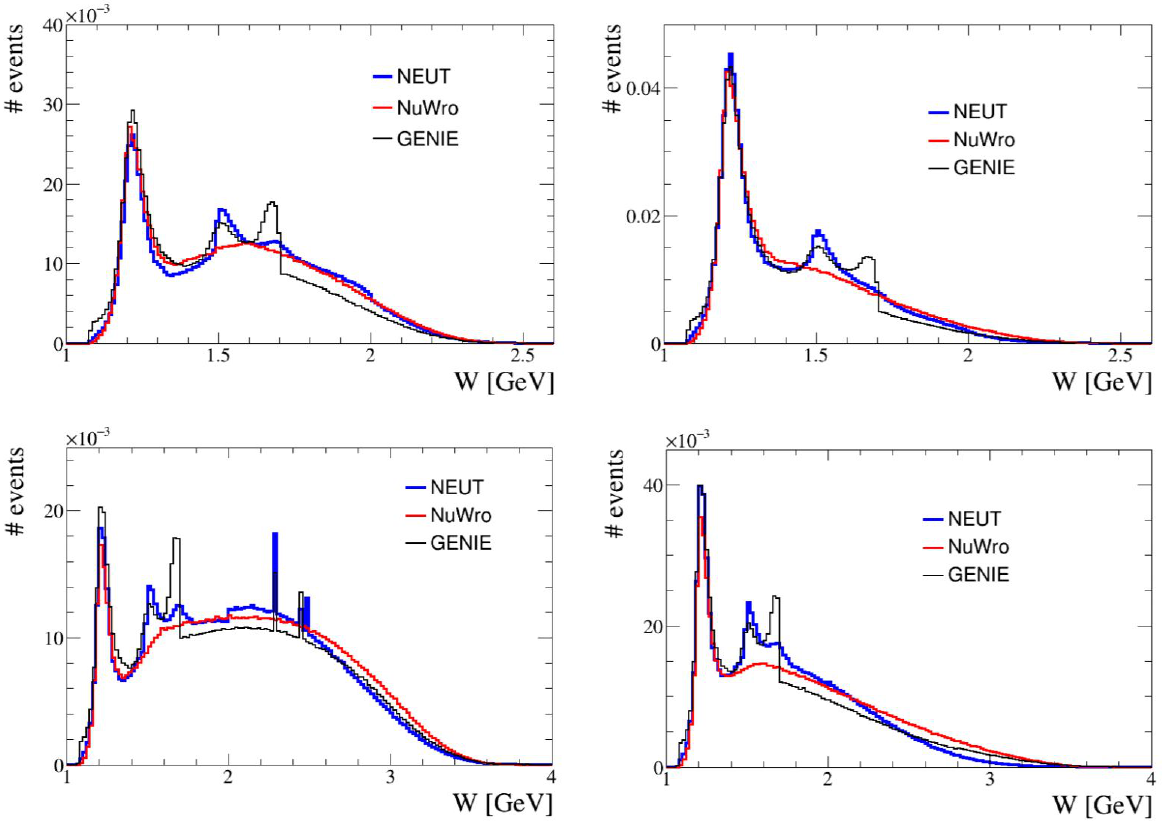
Figure 163. These plots show a comparison of the predictions for the W distibution for three neutrino event generators (NEUT 5.4.0, GENIE 2.12.10, and NuWro 18.021) for interactions on argon with E ν = 2.5 GeV on the top and on iron for E ν = 6.0 GeV on the bottom. Neutrino interactions are shown on the left side and antineutrino interactions are shown on the right side. Figures from Bronner in reference